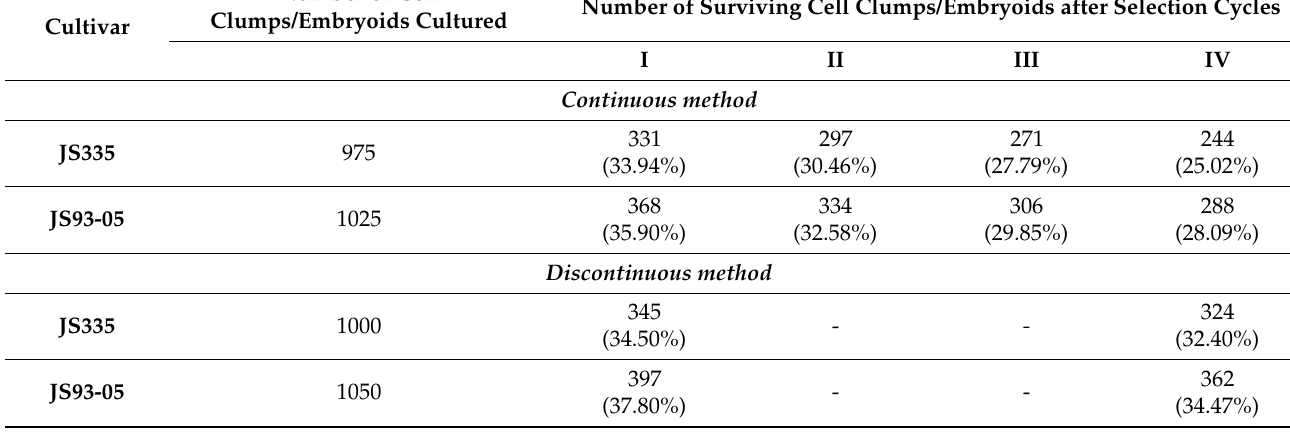
Table 5. Response of cell clumps/embryoids obtained from embryogenic cell suspension culture of soybean to the lethal concentration of